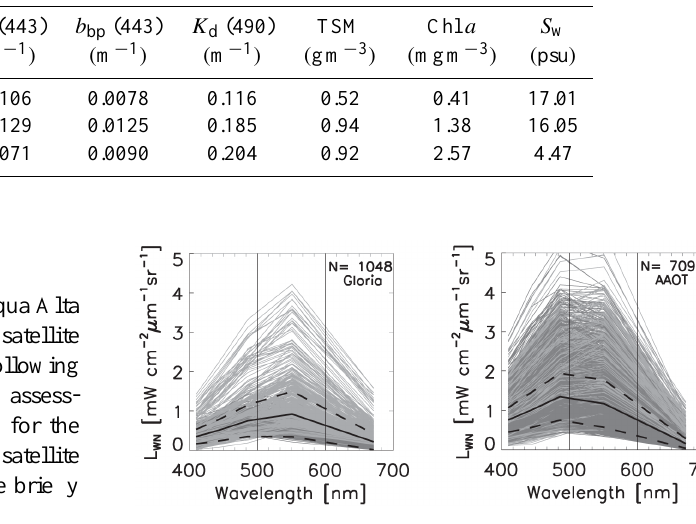
Figure 2. AERONET-OC Level-2 L WN spectra from the GLR and AAOT sites. The thick black line indicates mean values, while the thick dashed lines indicate ± 1 standard